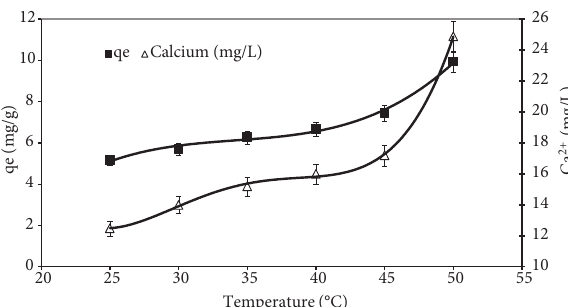
Fig. 5. Temperature effects on Cu 2+ adsorption onto